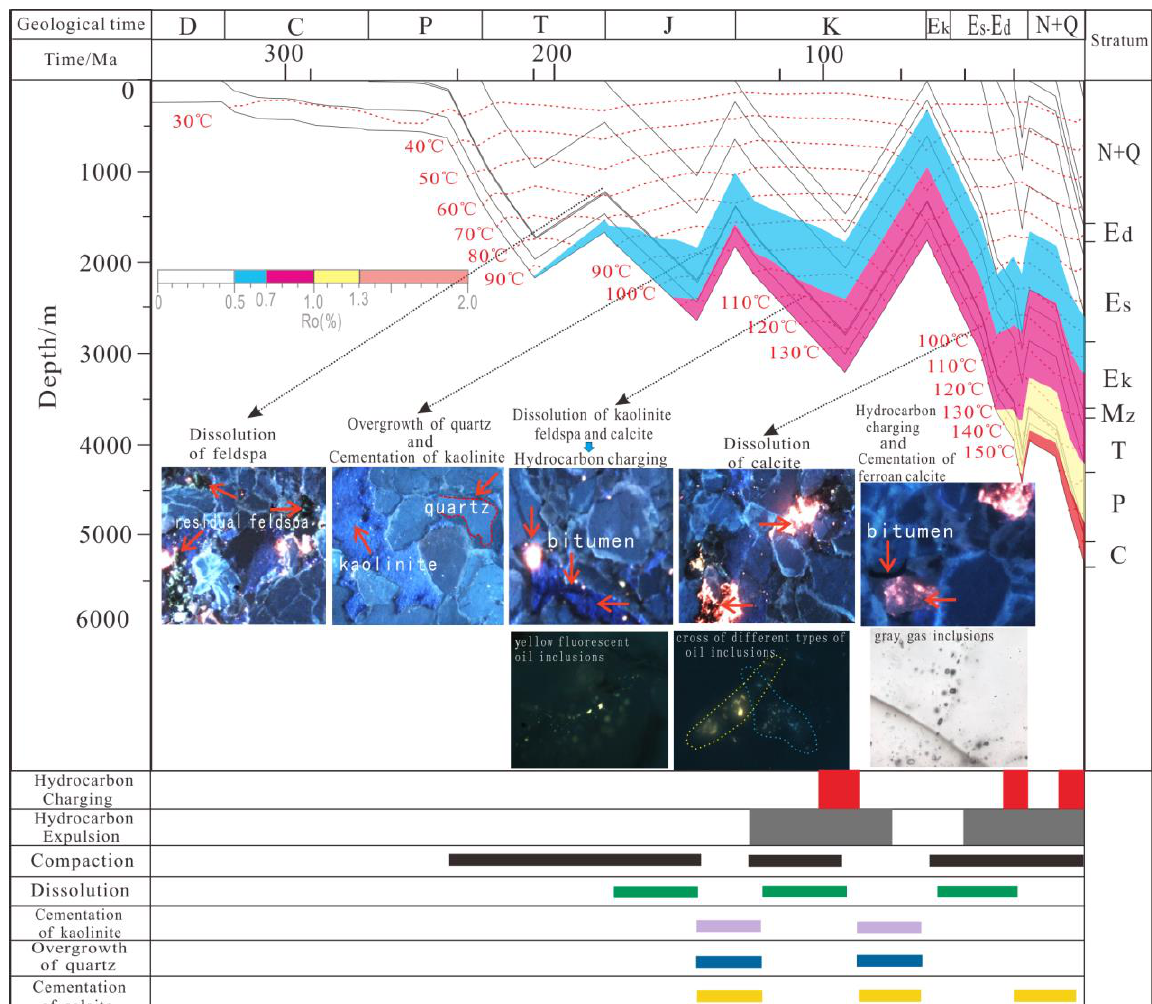
Figure 11. Burial – thermal history of strata and hydrocarbon charging in the Permian reservoirs of the Wumaying buried hill.